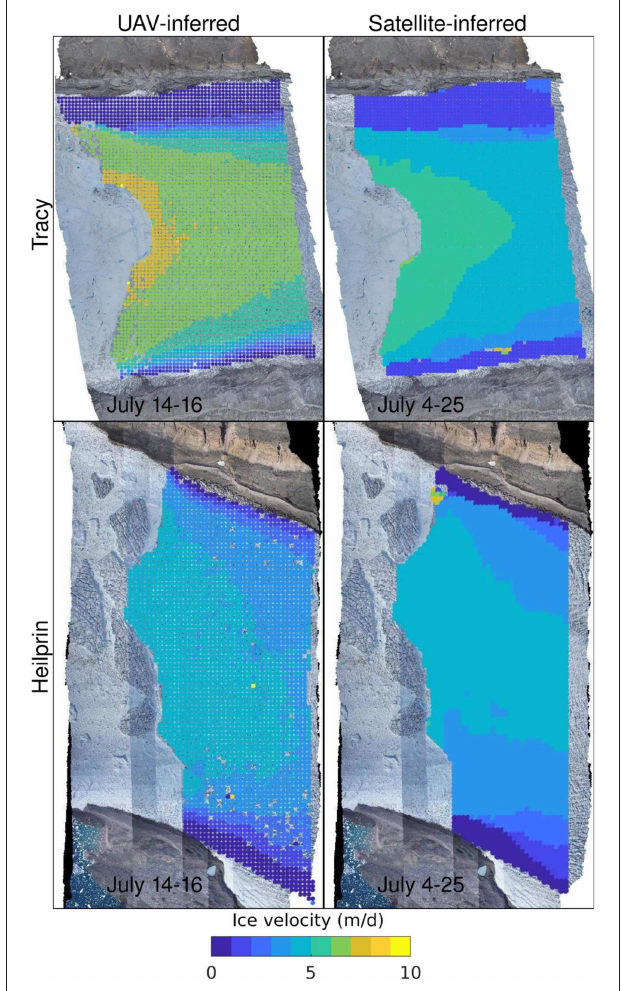
FIGURE 6 | Horizontal ice speed inferred by UAV (2 days separation, left panels) and satellite images (21 days separation, right panels) in July 2017 at Tracy (top panels) and Heilprin (bottom panels) glaciers. The velocity directions (not shown) are aligned with the fjord.